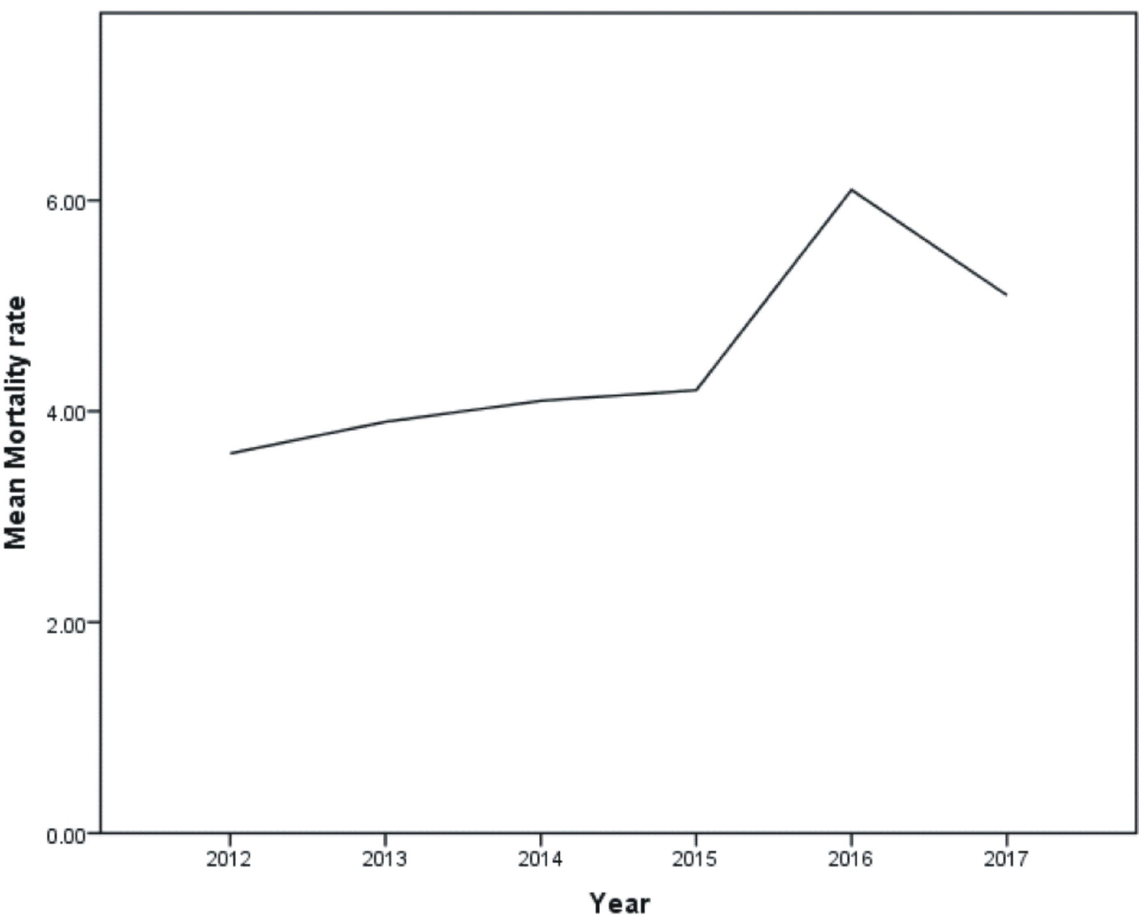
Fig 2. Mortality rates of the studied years